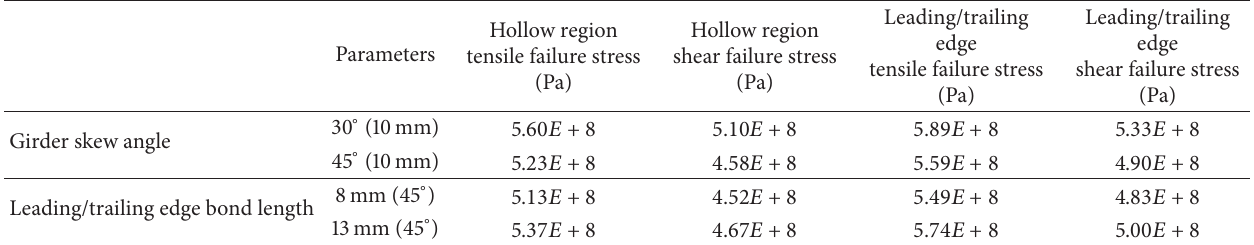
Table 4: The relation between structure parameters and bond strength.